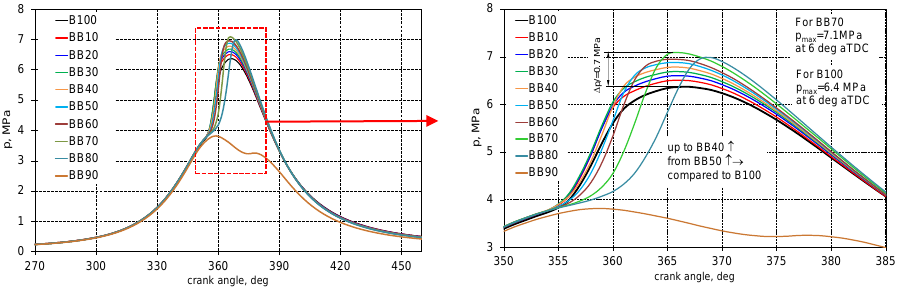
Figure 4. Mean pressure trace for analyzed cases.